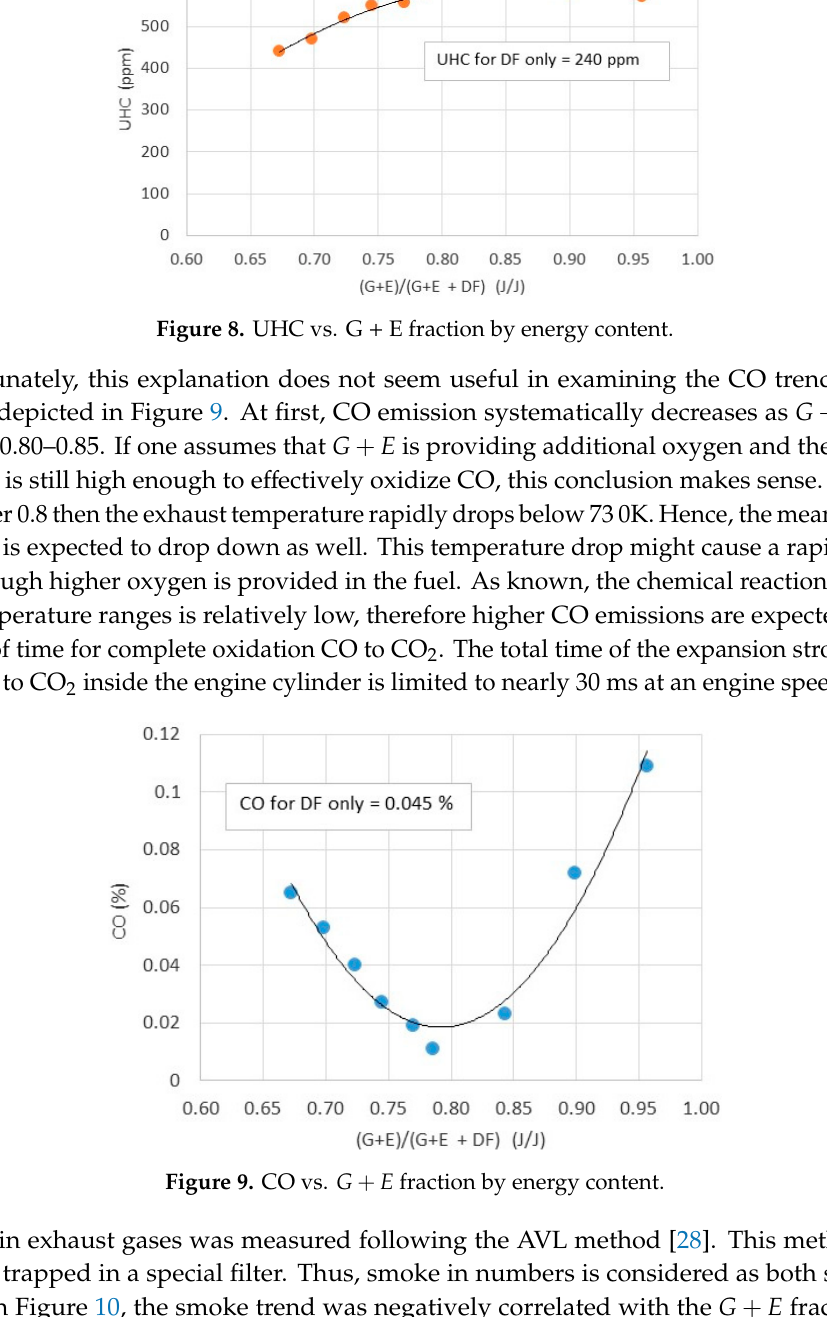
Figure 10. Smoke vs. 𝐺 + 𝐸 fraction by energy content.